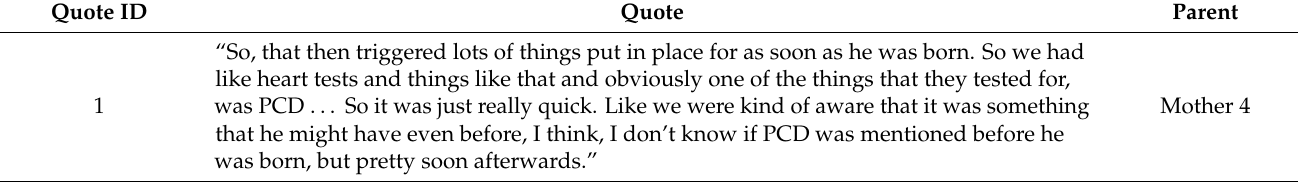
Table 3. Quotes from parents on the impact of a PCD